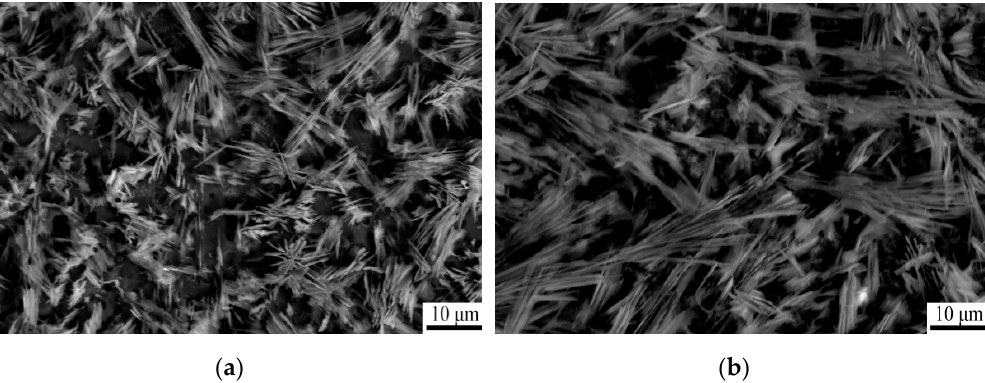
Figure 5. SEM images of the Ti-15%Mo/TiB composite microstructure in the weld area after etching: ( a ) room temperature (without pre-heating), ( b ) 600 °C.